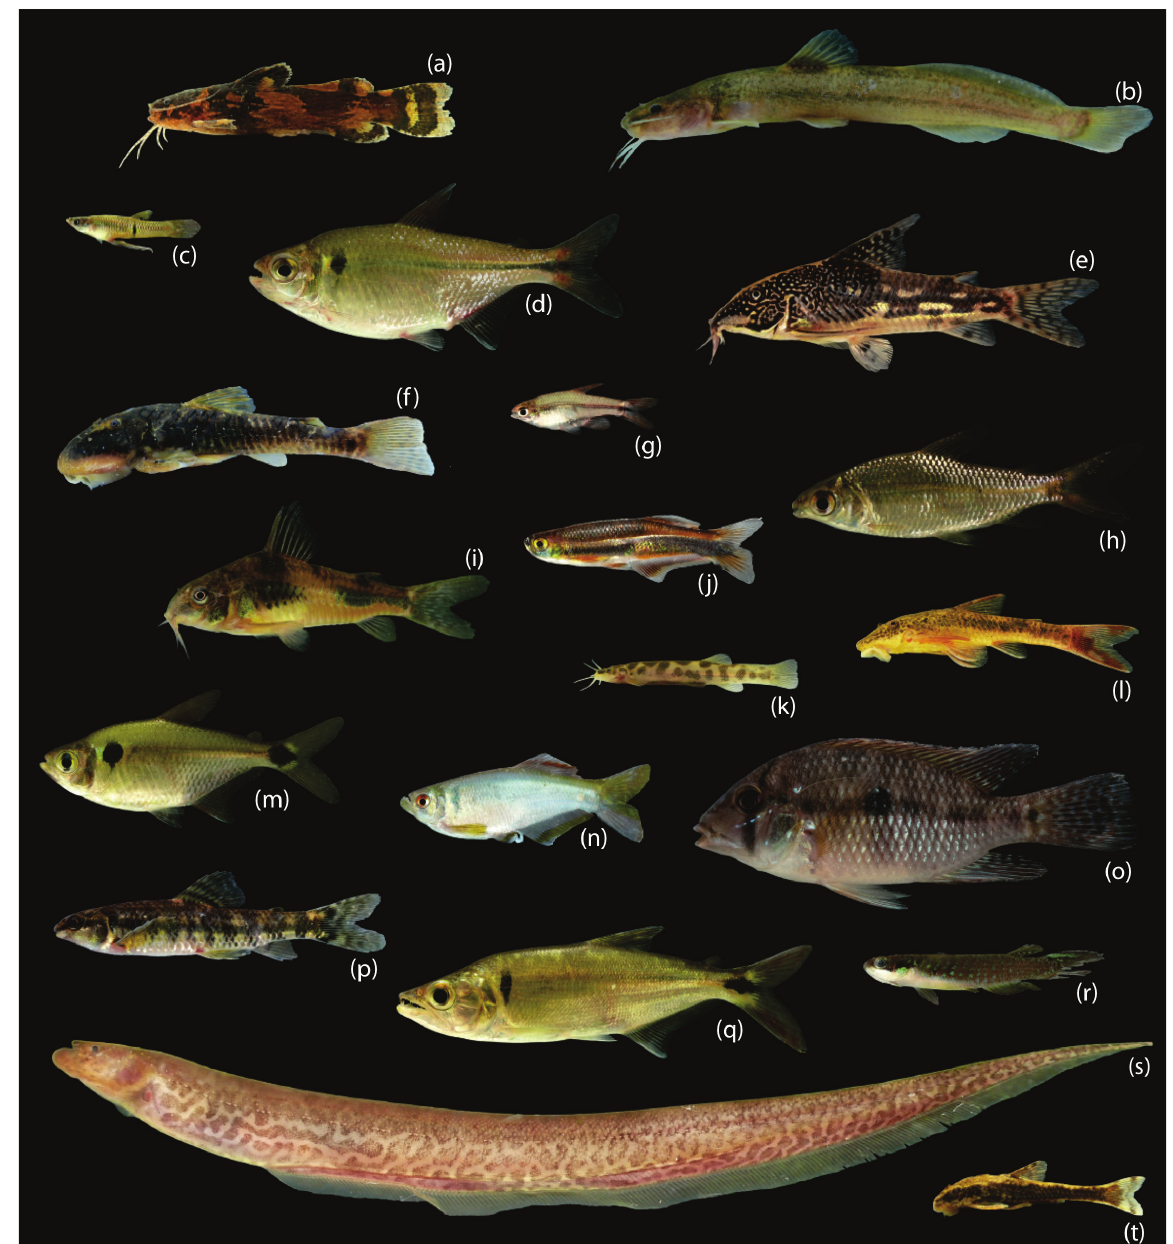
Fig. 2. Samples of some of the freshwater fish species of the Brazilian coastal drainages: a. Microglanis cottoides ((Boulenger, 1891) UFRGS 20930; 43.2 mm SL, standard length), b. Heptapterus sp. (UFRGS 20970; 89.2 mm SL), c. Phalloceros sp. (UFRGS 18596; 22 mm SL), d. Deuterodon singularis Lucena & Lucena, 1992 (UFRGS 20728; 59.6 mm SL), e. Scleromystax barbatus ((Quoy & Gaimard, 1824) UFRGS 18832; 65 mm SL), f. Pareiorhaphis splendens ((Bizerril, 1995) UFRGS 20971; 57.4 mm SL), g. Spintherobolus ankoseion Weitzman & Malabarba, 1999 (UFRGS 20923; 23.7 mm SL), h. Cyphocharax santacatarinae ((Fernández-Yépez, 1948) UFRGS 20918; 46.9 mm SL), i. Corydoras ehrhardti Steindachner, 1910 (UFRGS 20938; 50 mm SL), j. Mimagoniates lateralis ((Nichols, 1913) UFRGS 20488; 30.5 mm SL), k. Trichomycterus cf. cubataonis Bizerril, 1994 (UFRGS 20937; 30 mm SL), l. Parotocinclus maculicauda ((Steindachner, 1877) UFRGS 20932; 44.1 mmSL), m. Probolodus oyakawai Santos & Castro, 2014 (UFRGS 18752; 45 mm SL), n. Mimagoniates rheocharis Menezes & Weitz- man, 1990 (UFRGS 20808; 54.2 mm SL), o. Geophagus brasiliensis ((Quoy & Gaimard, 1824)UFRGS 20919; 72.5 mm SL), p. Characidium pterostictum Gomes, 1947 (UFRGS 18563; 55 mm SL), q. Oligosarcus hepsetus ((Cuvier, 1829) UFRGS 18571; 65 mm SL), r. Atlantirivulus cf. luelingi ((Seegers, 1984) UFRGS 21033; 31.5 mm SL), s. Gymnotus pantherinus ((Steindachner, 1908) UFRGS 20928; 186 mm SL), and t. Pseudotothyris ignota Martins, Britski & Langeani, 2014 (UFRGS 20934; 33.2 mm SL). Photo credits: Tiago P.